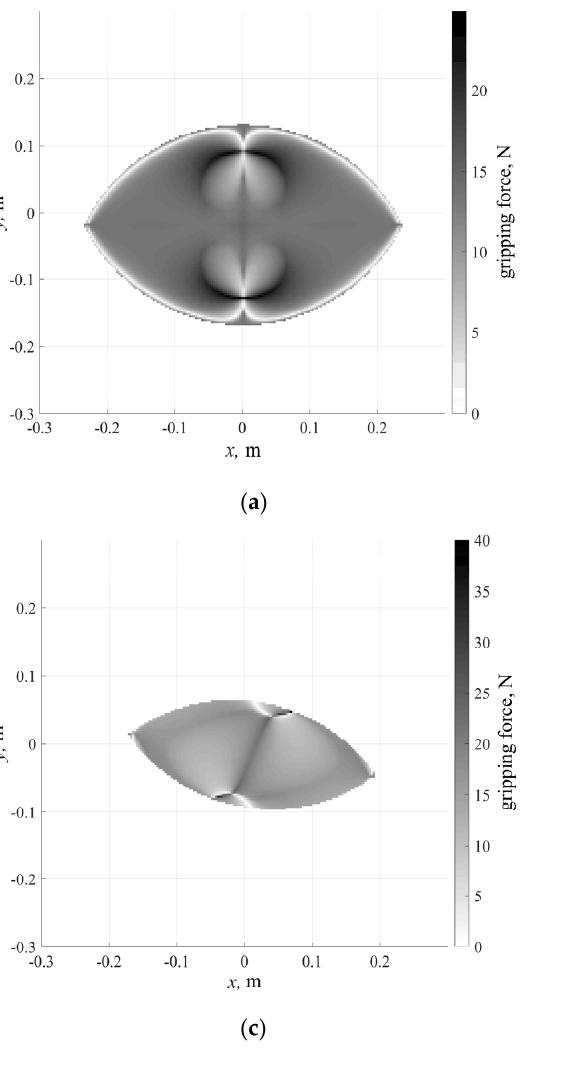
Figure 6. Distribution of the maximum gripping force along the workspace for s = 0.18 m and dif- ferent values of φ : ( a ) φ = 0 deg; ( b ) φ = 15 deg; ( c ) φ = 30 deg; ( d ) φ = 45 deg. different values of ϕ : ( a ) ϕ = 0 deg; ( b ) ϕ = 15 deg; ( c ) ϕ = 30 deg; ( d ) ϕ = 45